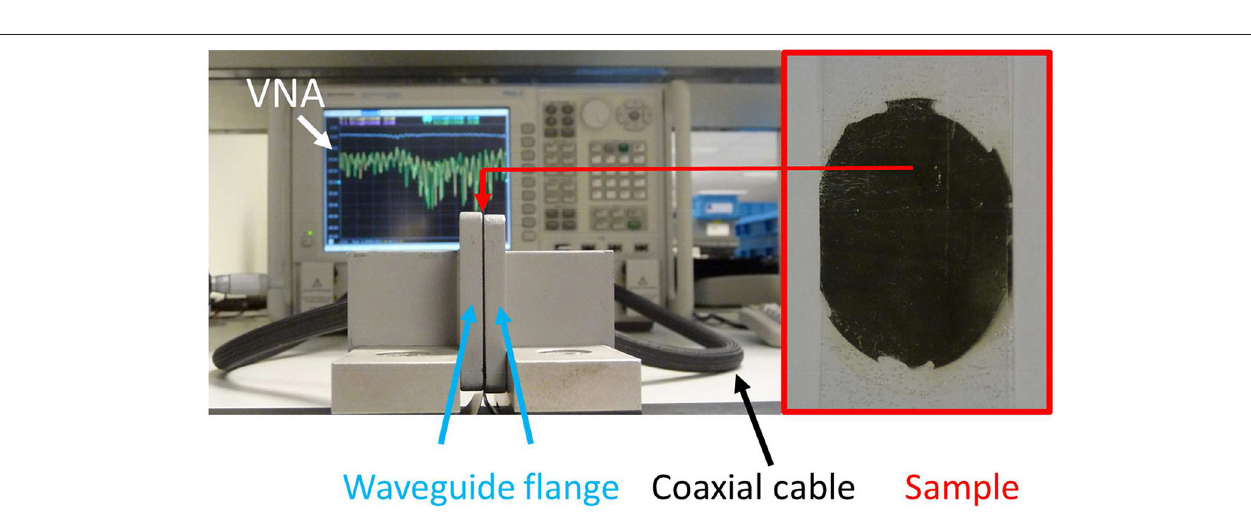
FIGURE 2 | Illustration of the measurement configuration used for our nanocomposites. Each sample is inserted between the two waveguide flanges that are connected to the Vector Network Analyzer (VNA) trough coaxial cables.